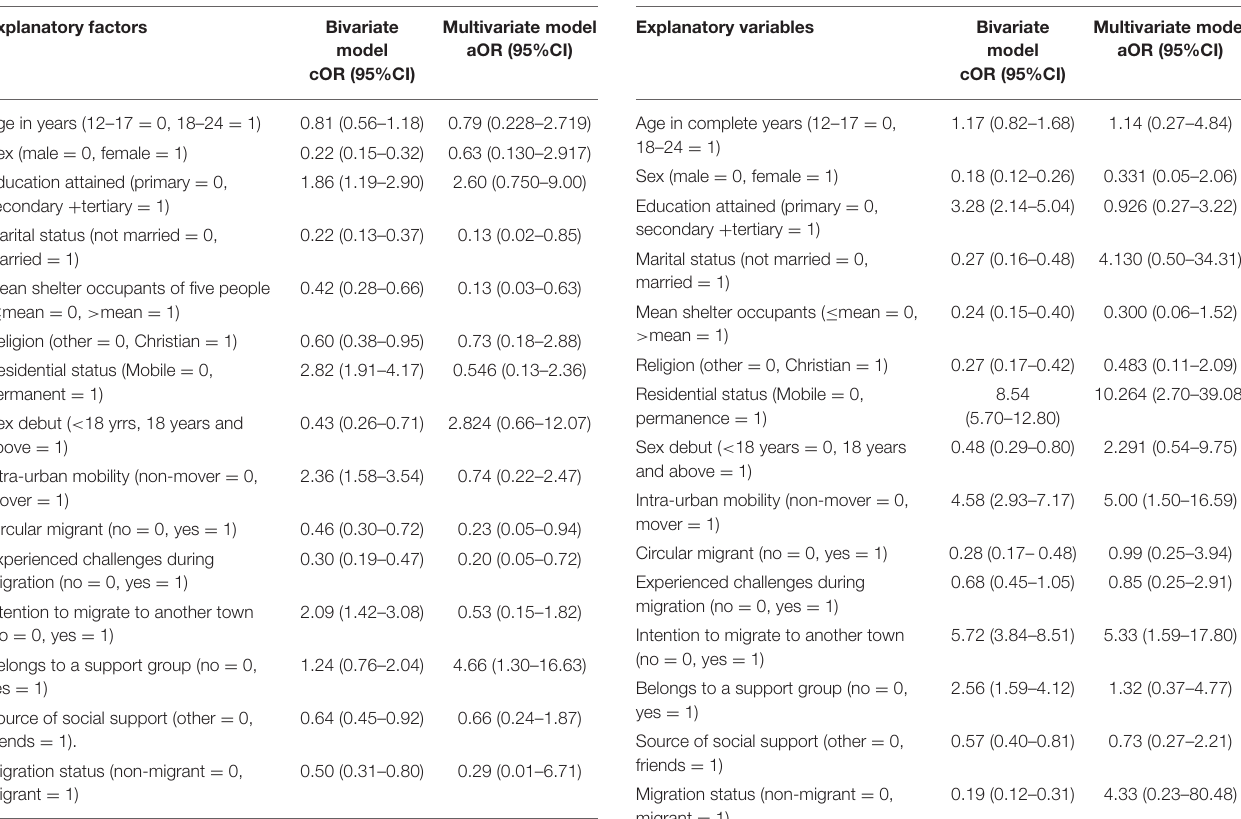
TABLE 3 | Model 2–Binary logistic regression of migration aspects and social demographic factors with contraceptive intentions among Street adolescents and youth in Kampala, Uganda,